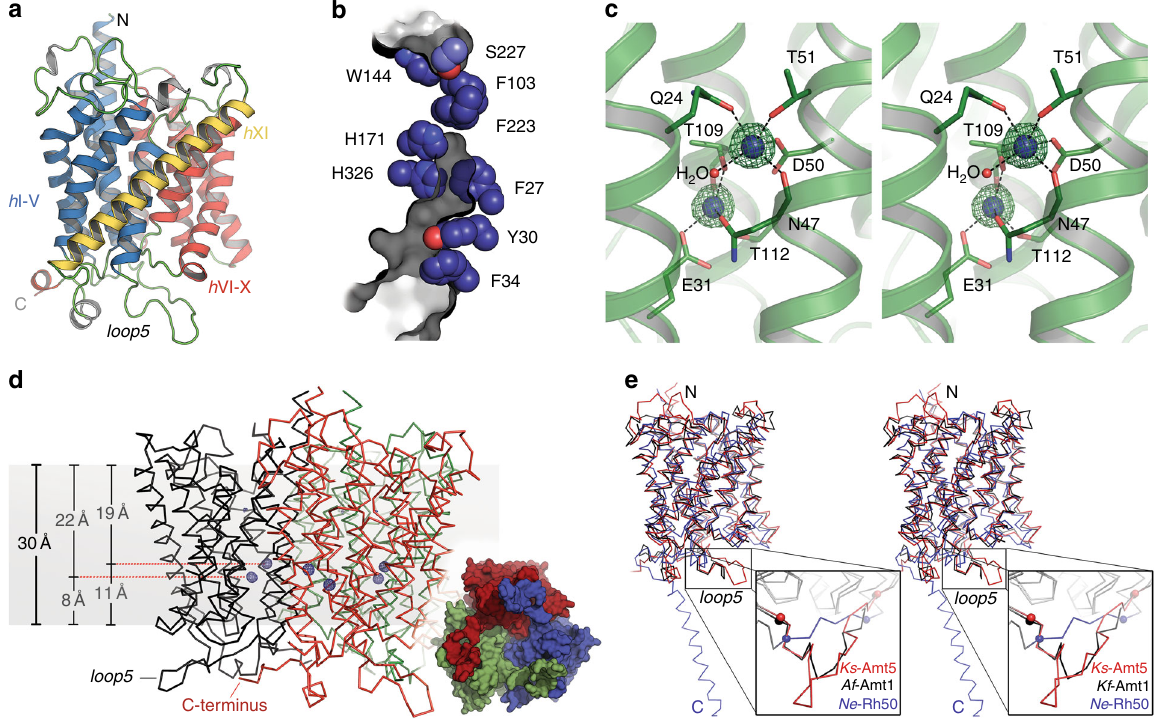
Fig. 3 High-resolution structure of the Amt domain of Ks -Amt5. a The monomer of Ks -Amt5 exhibits the typical transporter fold of Amt/Rh family proteins, with two groups of fi ve transmembrane helices ( h I-V, h VI-X) related through a twofold pseudosymmetry axis in the membrane plane, stabilized through the clamping helix h XI. The C-terminal HK domain was unde fi ned due to structural disorder. b The Amt domain retains all functionally relevant residues (orientation as in a ), in particular the selectivity fi lter (W144/S227), the Phe gate (F103, F223) and the His pair (H171, H326). However, in comparison with the Af -Amt1 transporter, for which the transport channel is overlaid in gray, an inward shift of the His pair in combination with three bulkier residues (F27, Y30, F34) in helix h I effectively closes the transmembrane transport pathway for ammonium ions. c Stereo representation of the NH 4 + binding sites within the membrane, with an F o – F c omit difference electron density map contoured at the 5.0 σ level. See Supplementary Figure 7 for the relative orientation of the ion binding site and the transport channel. d Side view of the trimer, indicating the location of the NH 4 + binding sites within the membrane (gray). The inset shows a bottom view of the trimer, highlighting how the C-termini extend over the neighboring monomer towards loop 5. e Superposition of Ks -Amt5 (red) with Af -Amt1 (black) and the Rh orthologue Ne -Rh50 (blue). The latter contains a helical extension at the C-terminus that adopts a